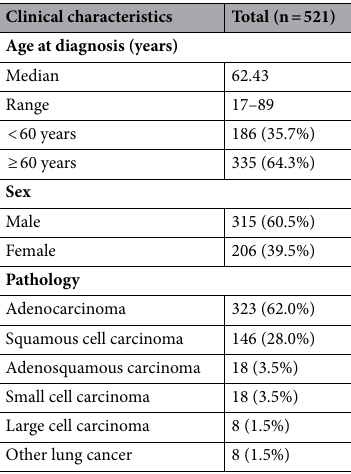
Table 2. Clinicopathologic features of 521 patients with lung